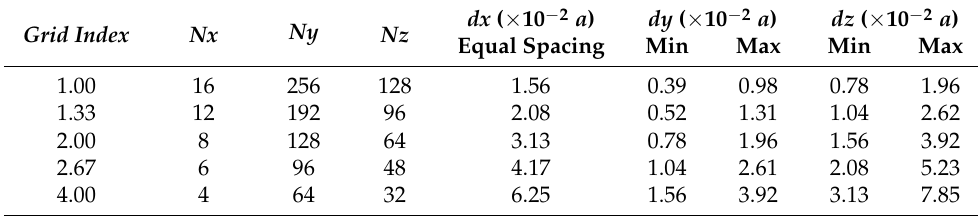
Table 1. Grid parameters for the grid dependency study of the flow in the square duct. Grid